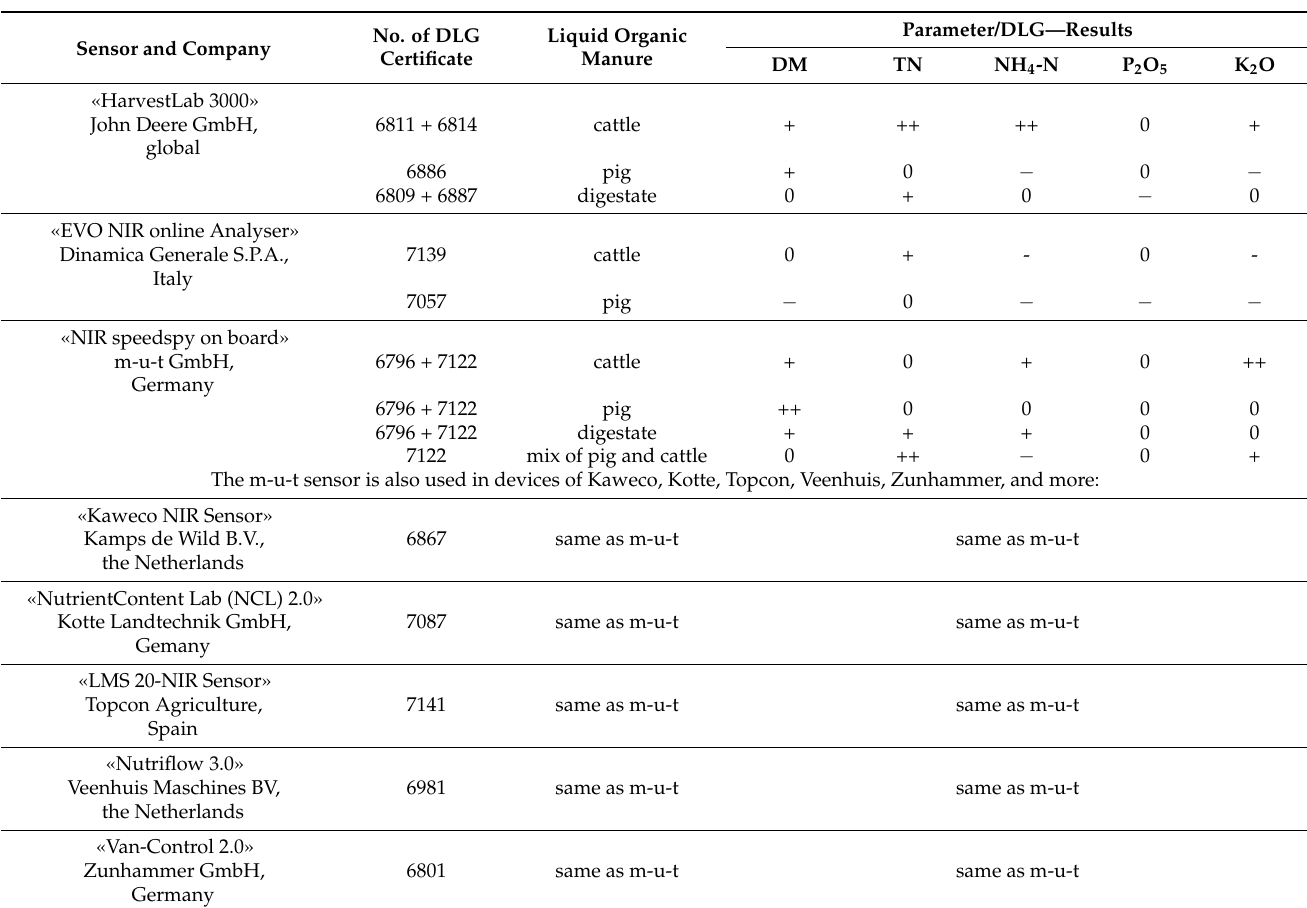
Table 7. Commercial NIR sensors, certified by the German